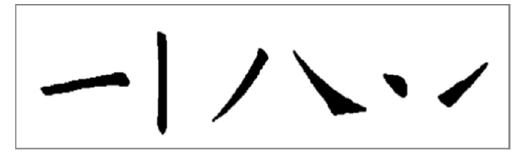
Figure 3. Basic six strokes of Chinese characters. The strokes form part of a character but have no meaning. The strokes are useful